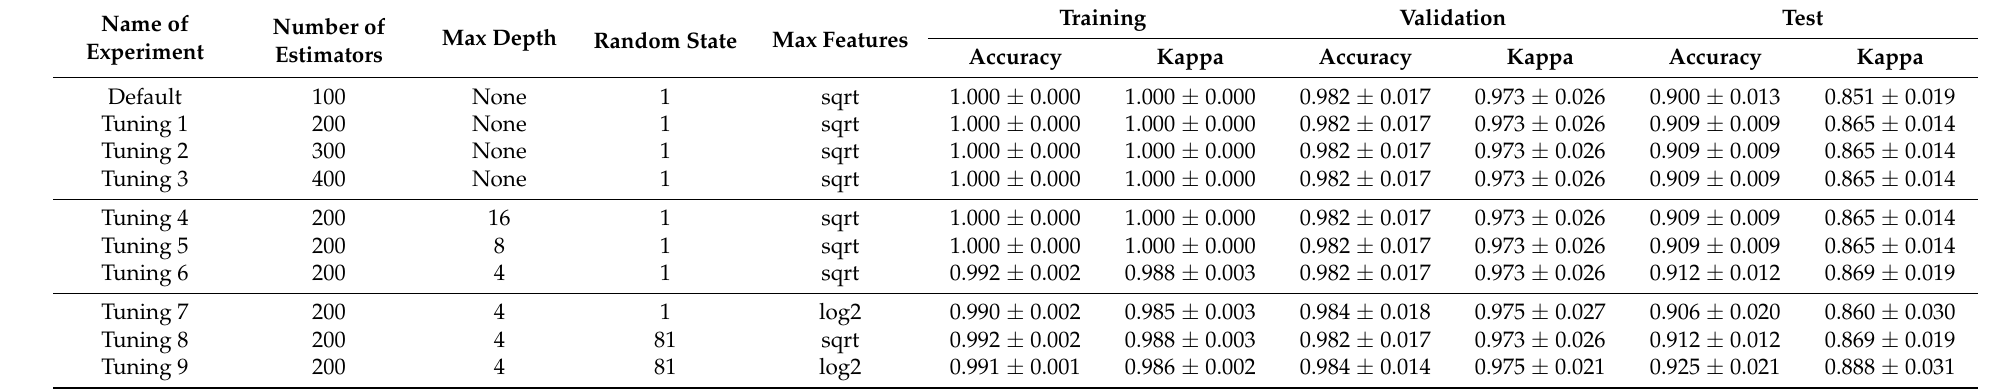
Table 3. Performance evaluation of parameter optimization of GerdNet-RF